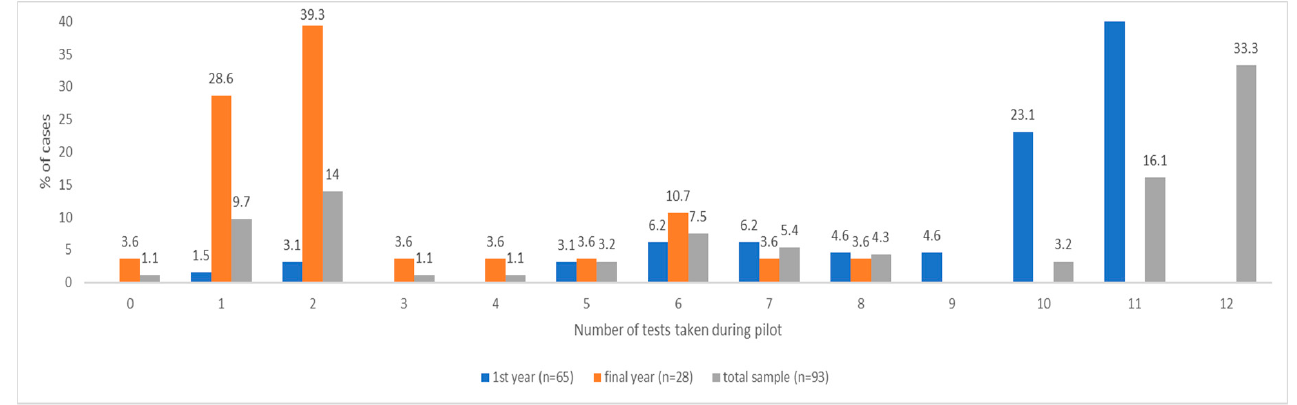
Figure 4. Reported frequency of number of PCR tests (swab and saliva) completed across 12 weeks of testing during P-ATS